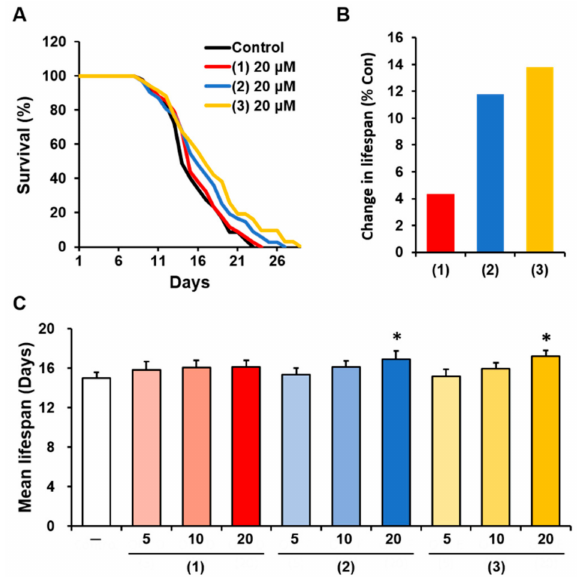
Figure 2. The longevity e ff ect of oleracone D–F ( 1 – 3 ) . ( A ) The lifespan curves obtained for compound-treated (20 µ M) and untreated wild-type nematodes under normal culture conditions. ( B ) The change in lifespan observed for the compound-treated (20 µ M) nematodes when compared to the control. ( C ) The mean lifespan of compound-treated (5, 10, and 20 µ M) and untreated wild-type nematodes was calculated from the survival curves. The statistical di ff erence between the curves was analyzed using a log-rank test. * p < 0.05 compared with the vehicle alone. All experiments were repeated in triplicate.